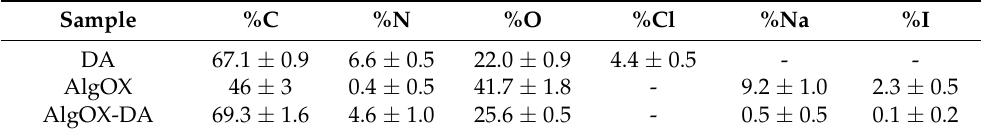
Figure 6. FT-IR spectra of pure DA (blue); pure Alg OX (green); and Alg OX-DA (pink). As can be seen, in the spectrum Table 1. XPS surface elemental percentages for DA, AlgOX, and AlgOX-DA Schiff base. The values of AlgOX, the band corresponding to the aldehyde vibration was not detected. are indicated as mean values averaged from at least three replicates; the errors are expressed as standard deviation ± 1 S.